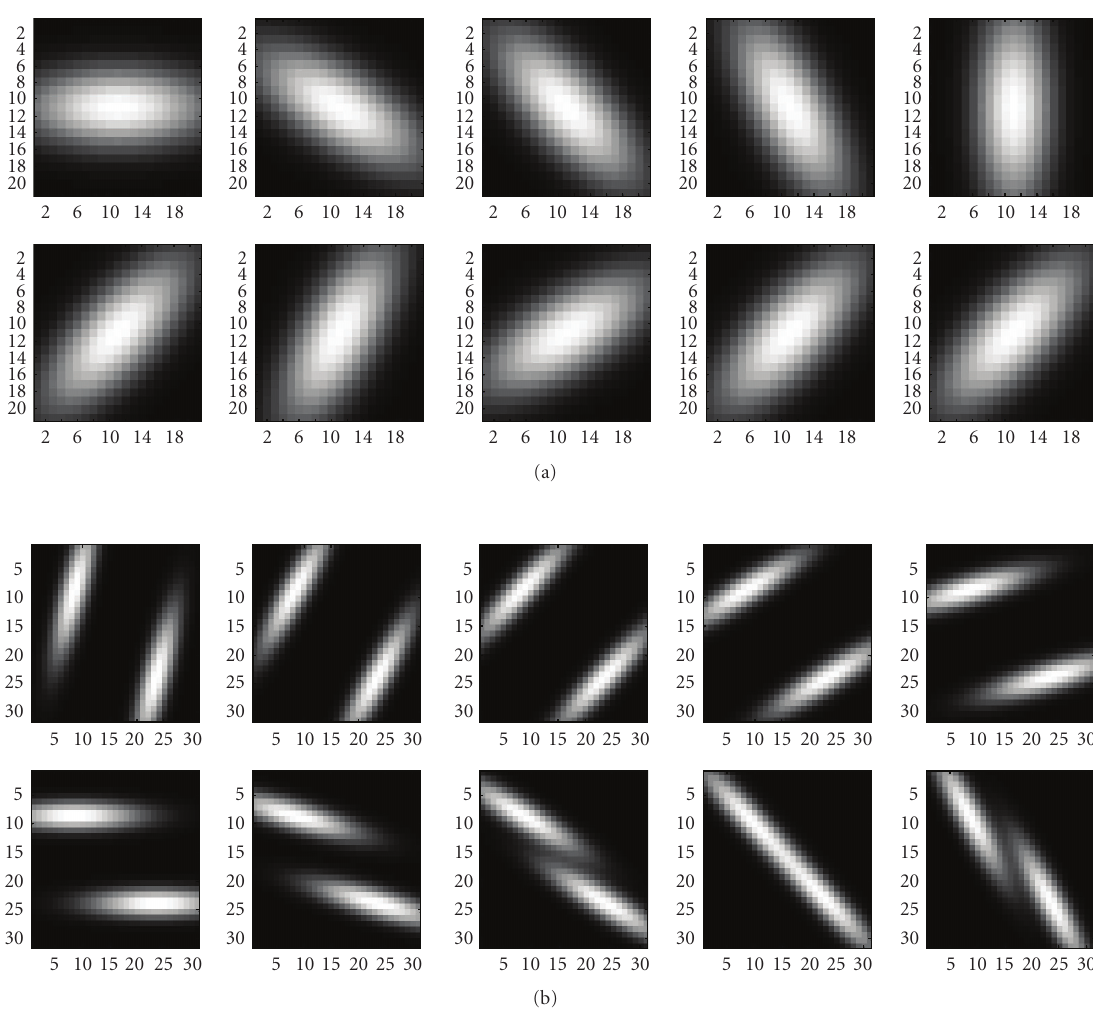
Figure 5: MF’s used in di ff erent orientations and descending scales for fine VP detection: (a) single GS-MF. (b) double GS-MF with dual foreground and background transition modeling and indicative scale